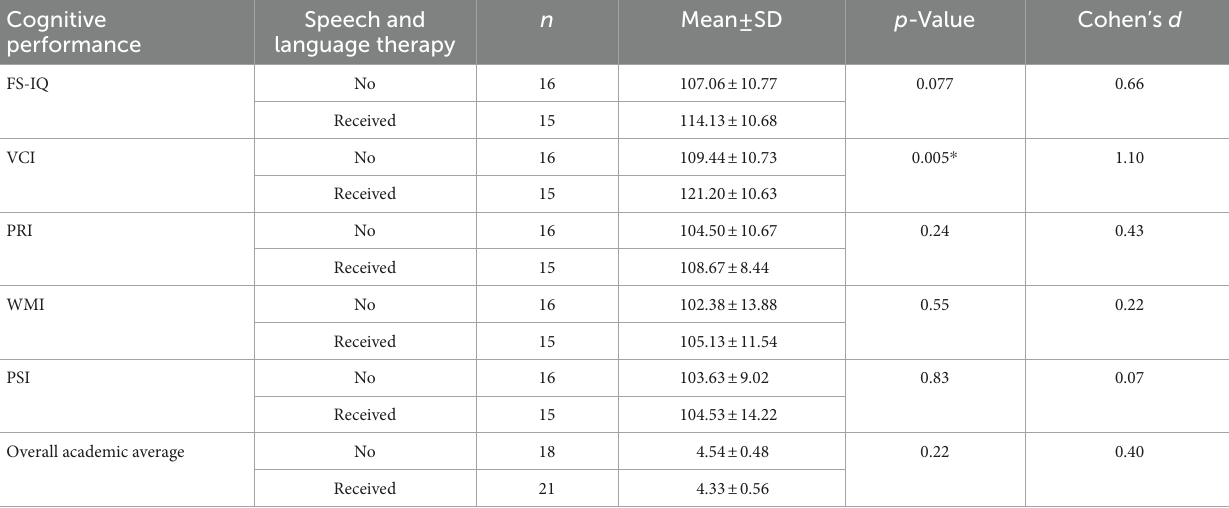
TABLE 7 Effect of speech and language therapy on IQ scores and overall academic average. Cognitive